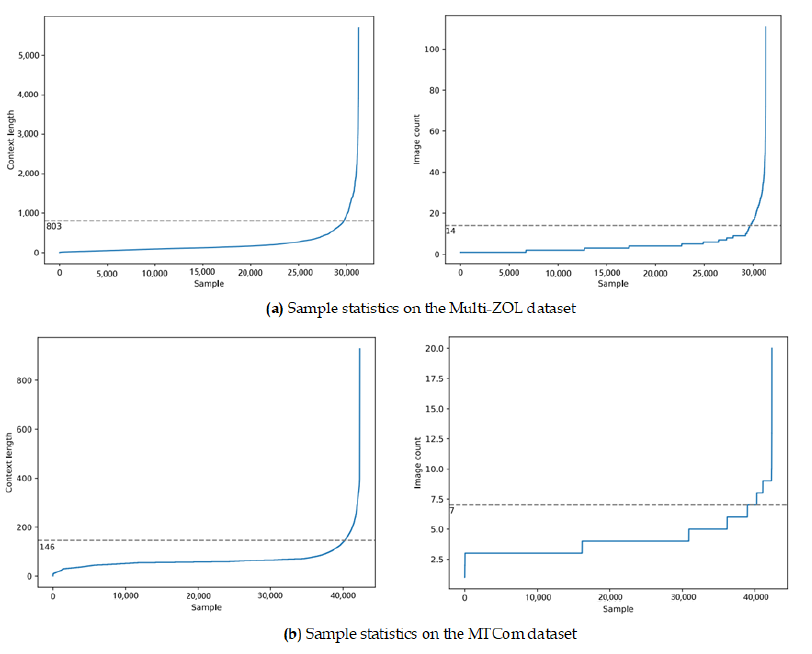
Figure 4. Average context length and image number on two multimodal datasets. ( a , b ) show the statistics of samples on the Multi-ZOL dataset and the MTCom dataset,